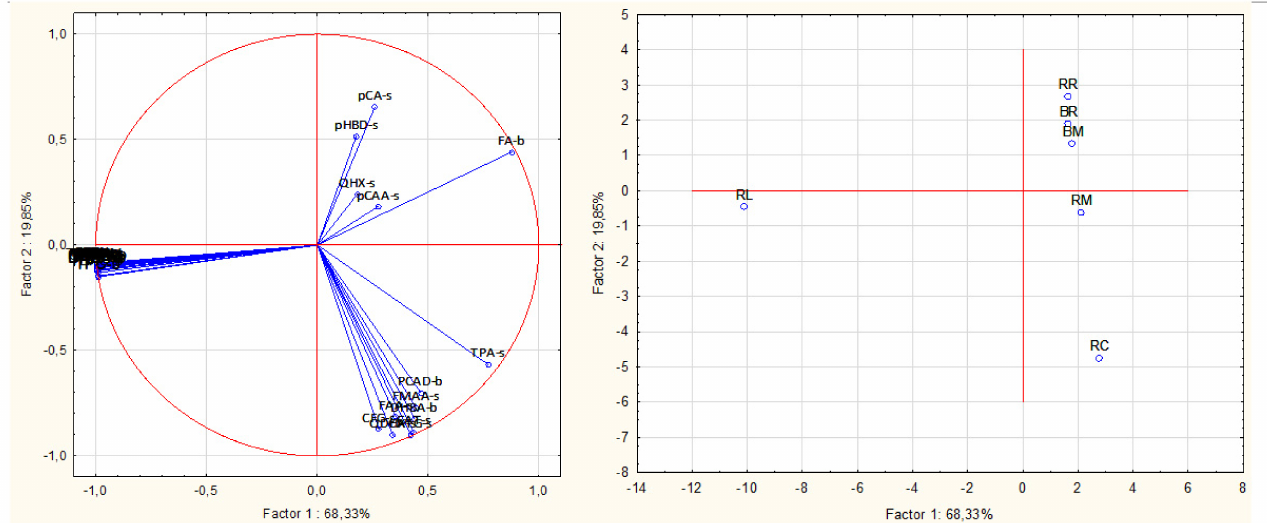
Figure 7. Factor loading and score plots for the phenolic compounds and antioxidant activities ( left ) and samples ( right ) during principal components analysis. Key: RR = raw white rice; RC = raw cowpea; RL = raw leaves; RM = raw mix; BR = boiled white rice; BM = boiled rice-cowpea mix; pCA-s = p -coumaric acid soluble free; pHBD-s = p -hydroxybenzaldehyde soluble free; QHX-s = quercetin hexoside soluble free; CAA = p -coumaroyl aldaric acid; TPA = quantified total phenolic acids; PCAD = protocatechuic aldehyde; FMAA = feruloyl methylaldaric acid; FAA = feruloyl aldaric acid; X-s = compound X soluble free fraction; pHBA = p -hydroxybenzoic acid; CFG = 1,3-Coumaroyl feruloyl glycerol; X-b = compound X insoluble bound fraction.